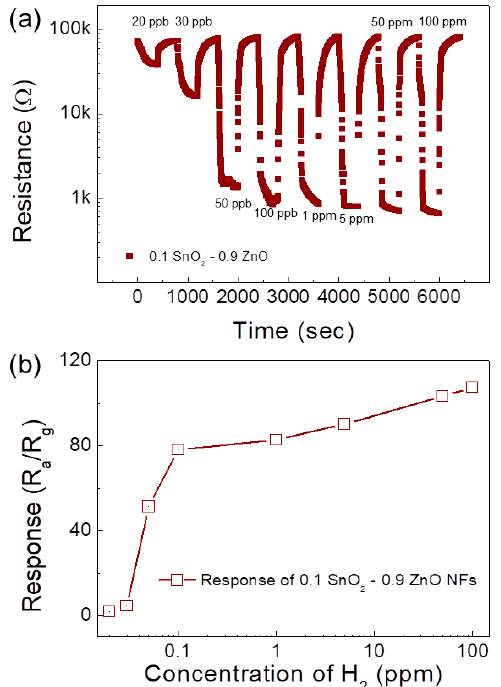
Figure 10. ( a ) Dynamic resistance curve of the 0.1 SnO 2 -loaded ZnO NF gas sensor towards 20 ppb to 100 ppm of H 2 gas. ( b ) Response versus H 2 gas concentration.